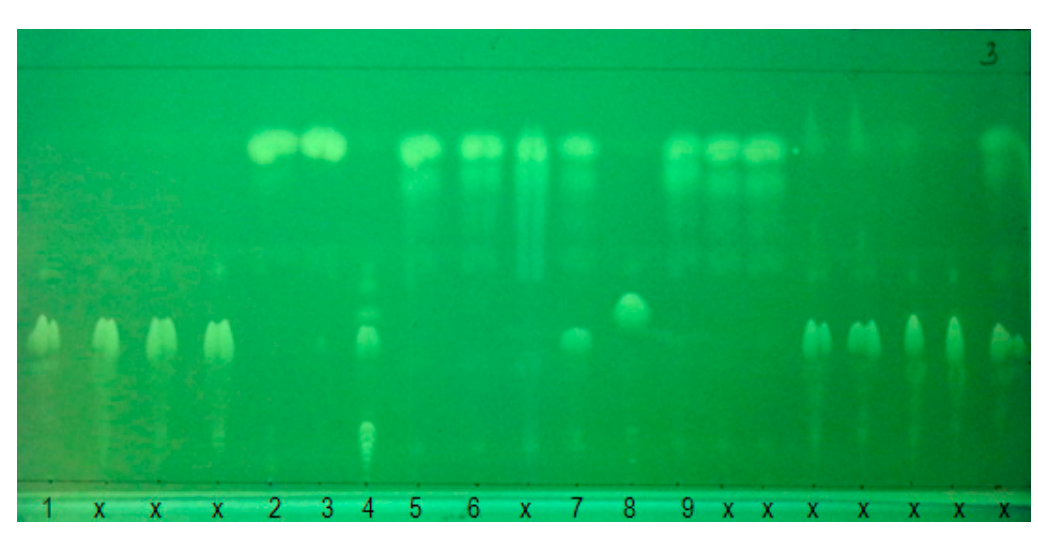
Figure 7. Chromatogram after third stage of plate development, l = 365 nm. The sample type is presented in Table 1, please refer; x—other commercially available lubricating oils.